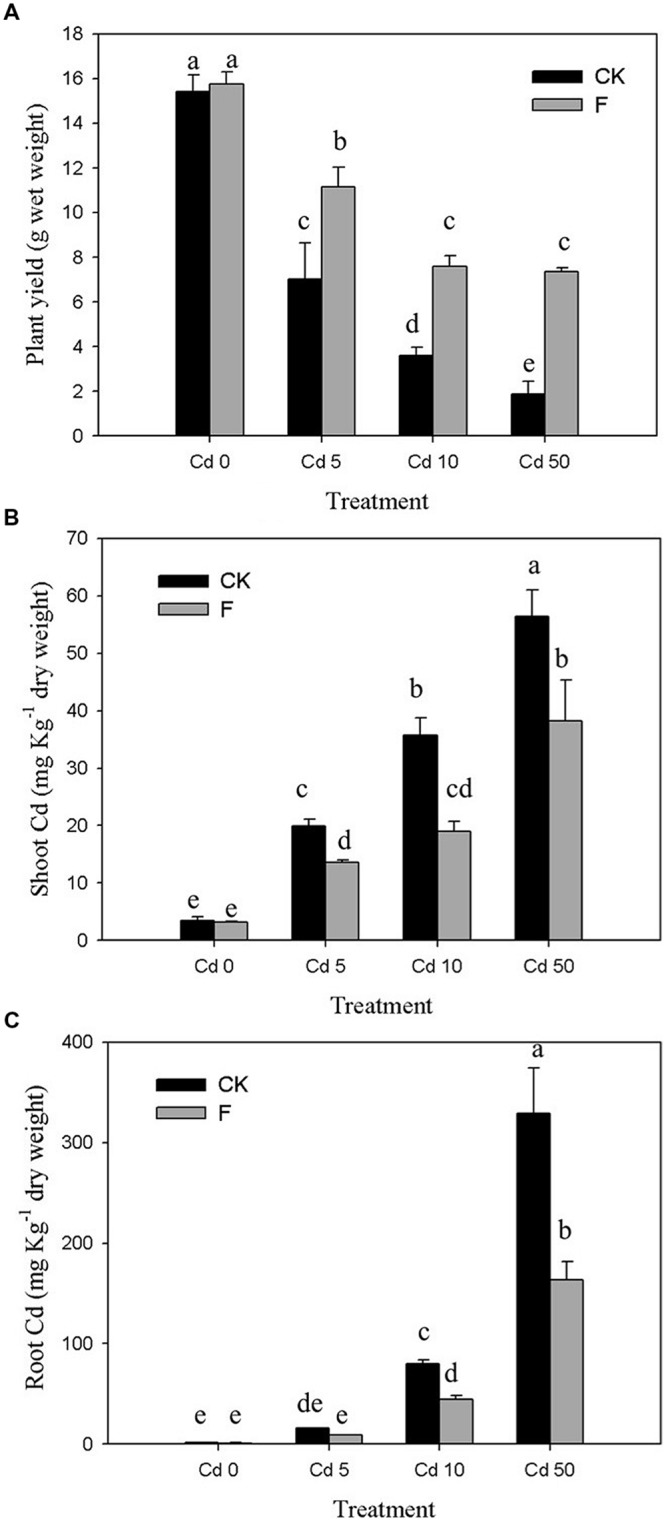
Effects of P. chrysogenum XJ-1 on the plant properties of pakchoi at various Cd levels. (A) Plant yield, (B) Cd uptake by plant shoots, and (C) Cd uptake by plant root. Bars with the same letter(s) are not significantly different at p > 0.05.